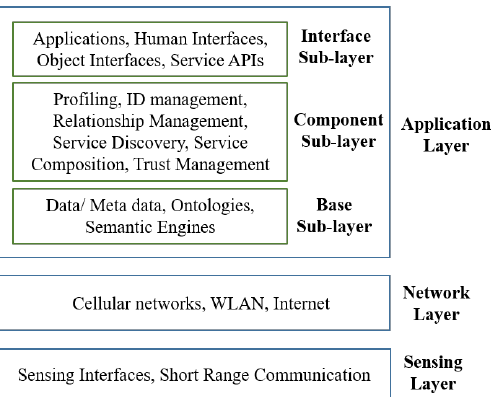
Figure 10. Social Internet of Things Representative Architecture for the IoT